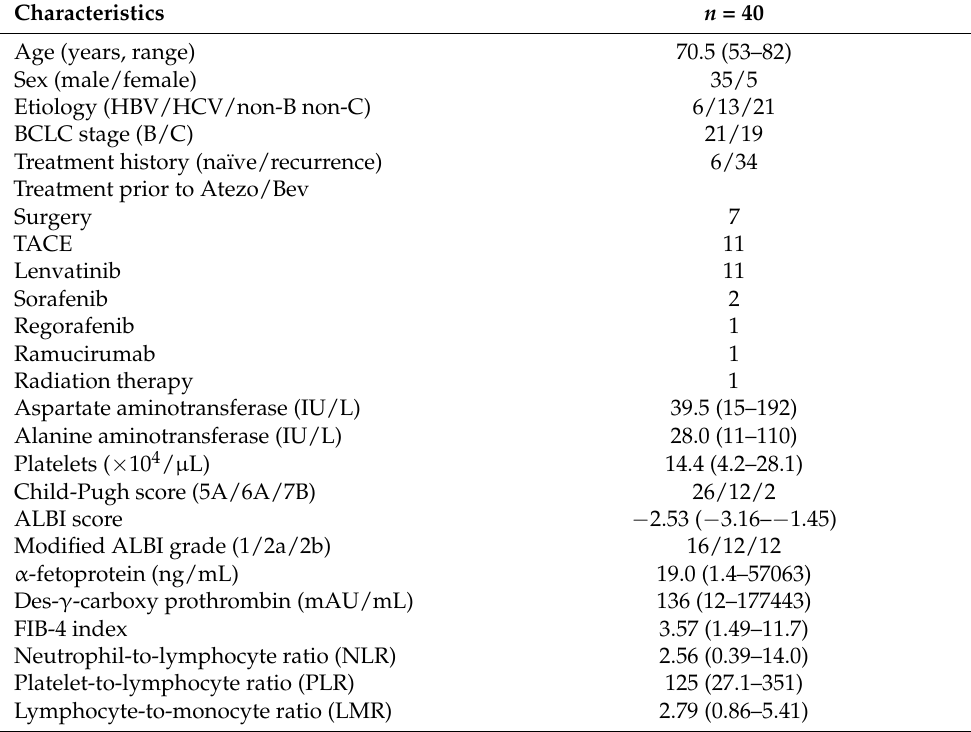
Table 1. Baseline characteristics of enrolled